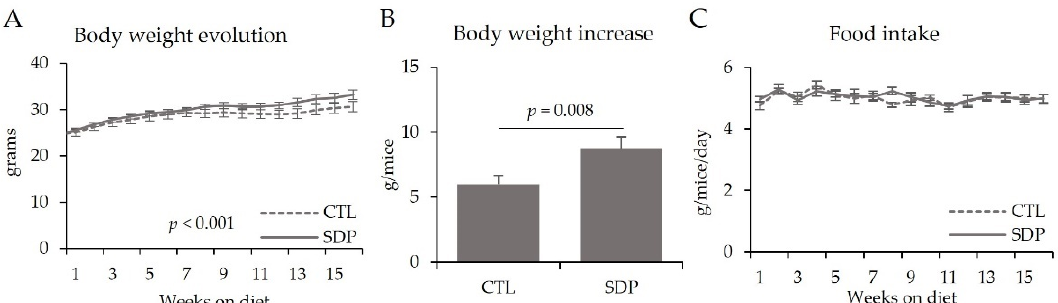
Figure 1. Body weight evolution ( A ), body weight increase ( B ) and food intake evolution ( C ) of SAMP8 mice during the experimental period. Results are expressed as mean ± SEM ( n = 11–12 mice/group). Statistics: t-Student test.